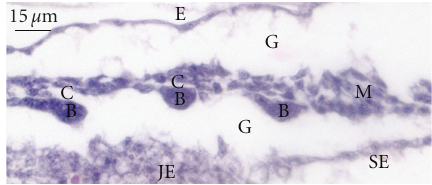
Figure 3: Section (plane indicated in Figure 2) through the neural plate anlage (N) with neural groove (arrowhead), developed in a half-chicken embryo after 1 day of culture. C, prechordal plate; M, cranial mesoblast. Harris hematoxylin eosin. Bar = 25 μ m.